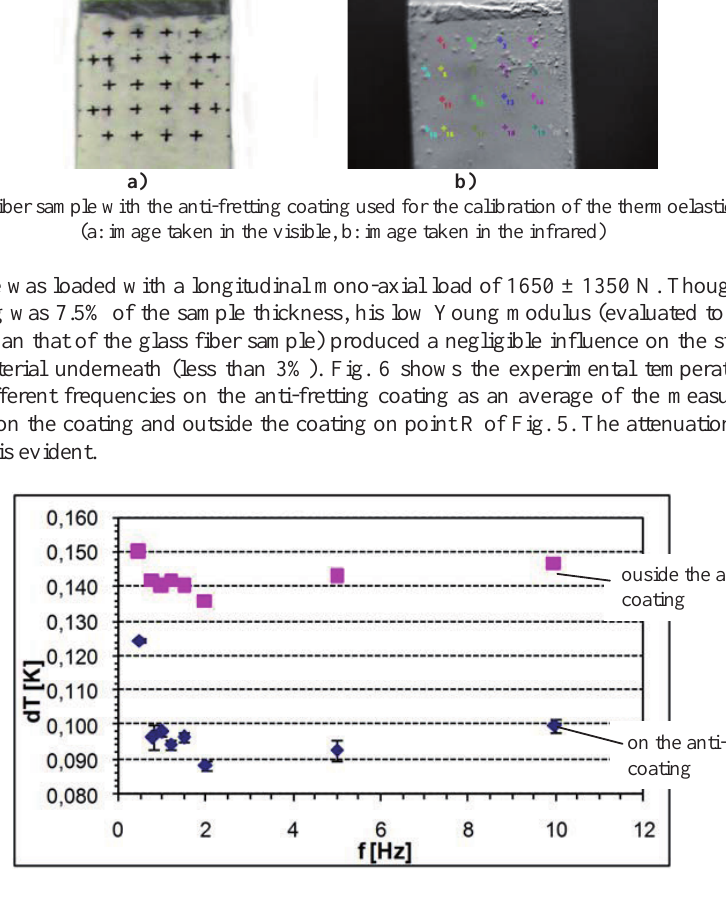
Fig. 6. Experimental temperature values obtained on the calibration sample at different frequencies The peak to peak stress induced in the sample was evaluated to be (cid:2)(cid:5) =34.4 MPa on the base